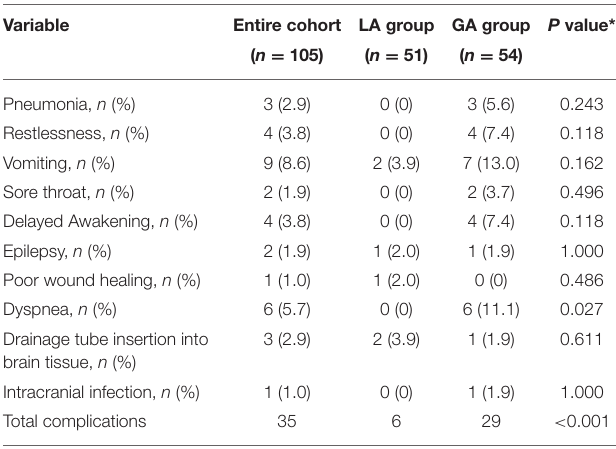
TABLE 4 | Postoperative